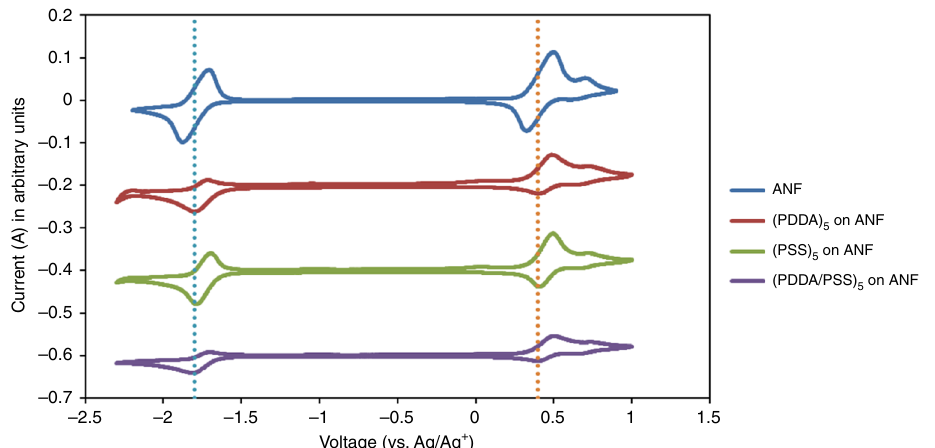
Fig. 2 Cyclic voltammagrams of aramid nano fi bre (ANF) coated glassy carbon electrodes after soaking in 0.01 M vanadium acetylacetonate/0.1 M tetrabutylammonium tetra fl uoroborate in acetonitrile solution for 10 days. Scan rate of 100 mV s − 1 with the fi fth